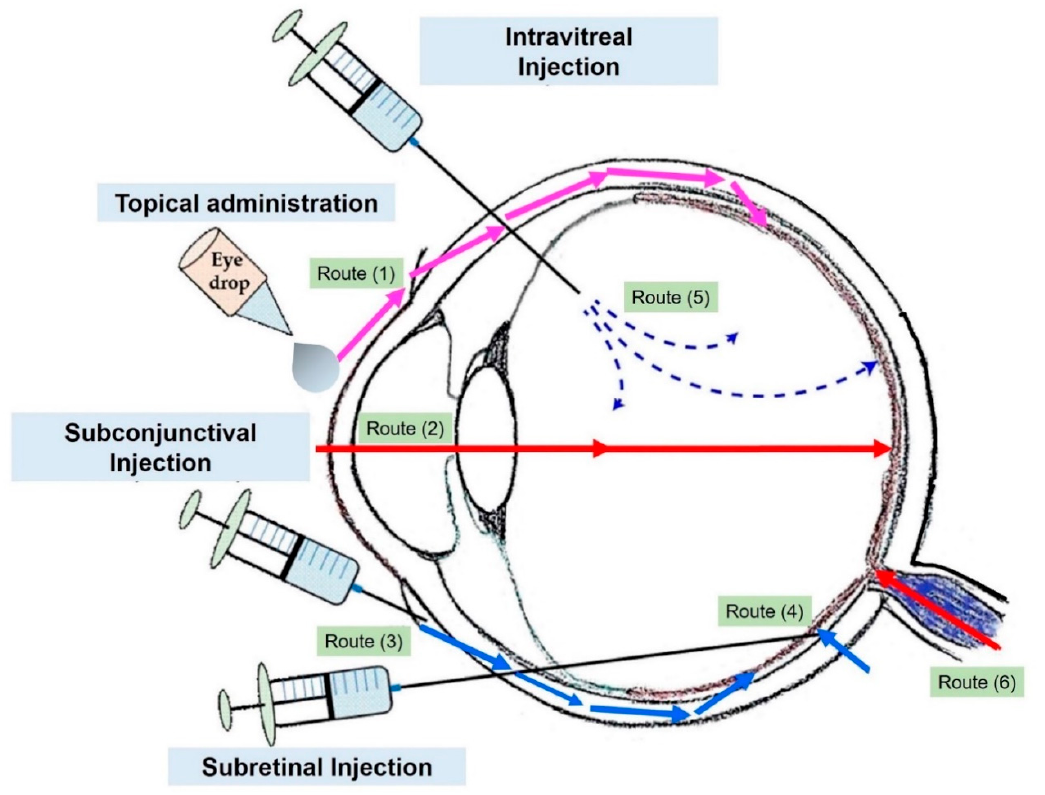
Figure 2. Common drug administration routes through the eye. Topical administration ( 1 , 2 ), subconjunctival injection (periocular route) ( 3 ), subretinal injection ( 4 ), and intravitreal injection ( 5 ). Adapted from reference